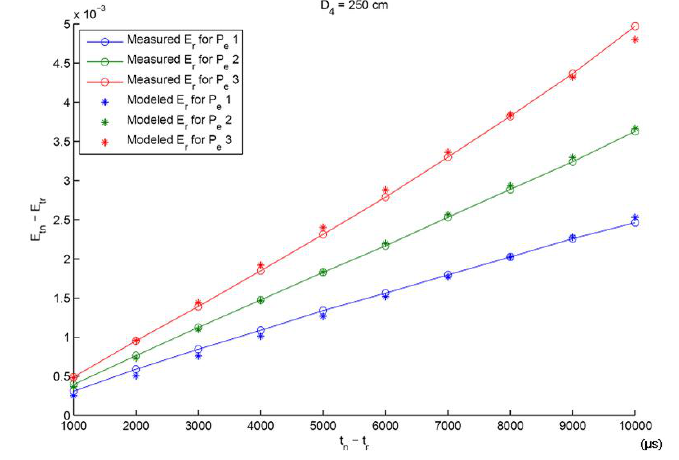
Figure 2. Representative results for the differential model calibration process. Three different emitter radiant intensities were considered by changing the diode polarization